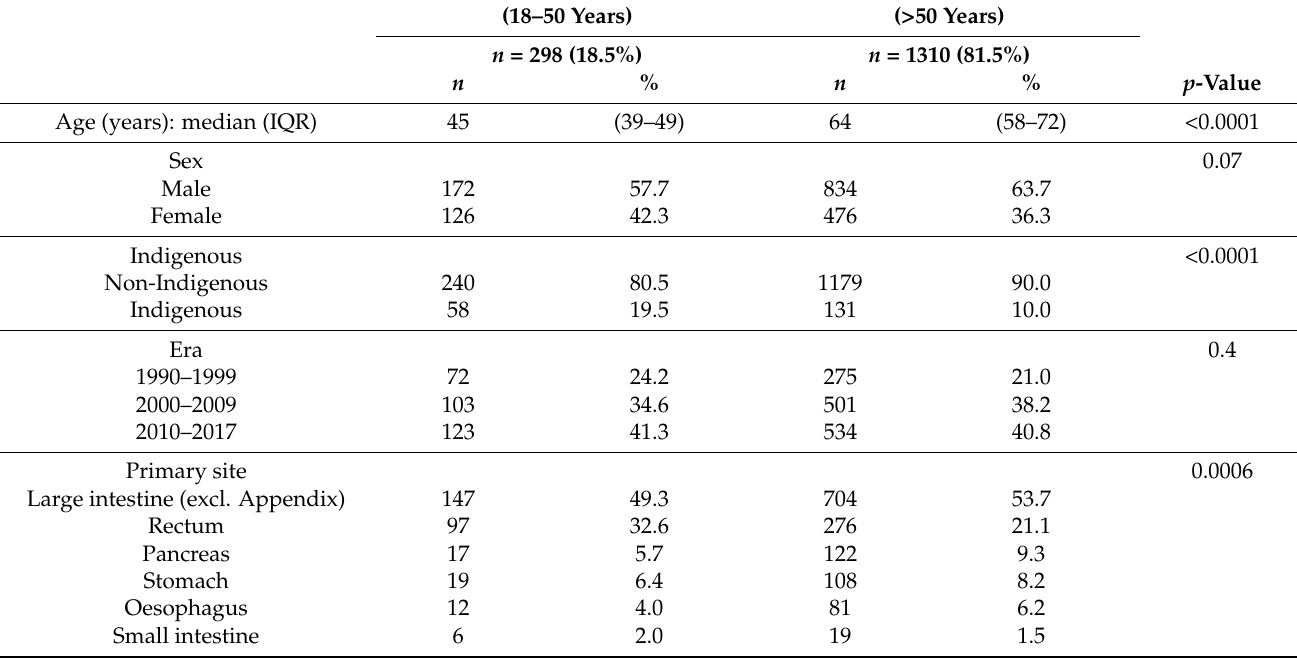
Table 1. Patient’s characteristics, era, and primary sites of cancer between two age groups ( n =